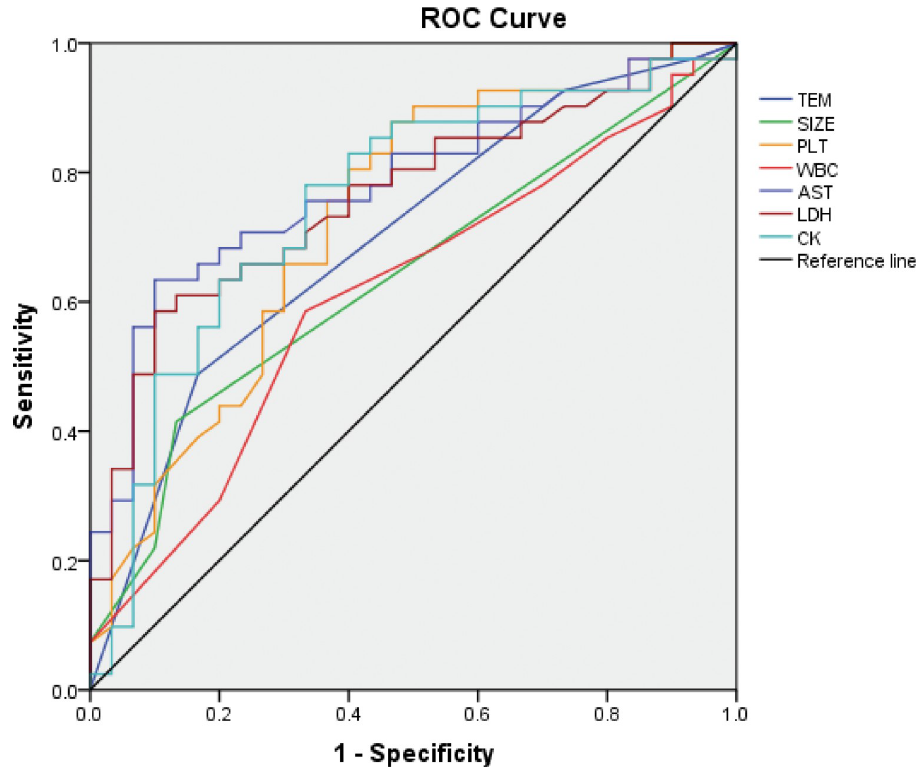
Fig 4. ROC curves for the prediction of the severity of